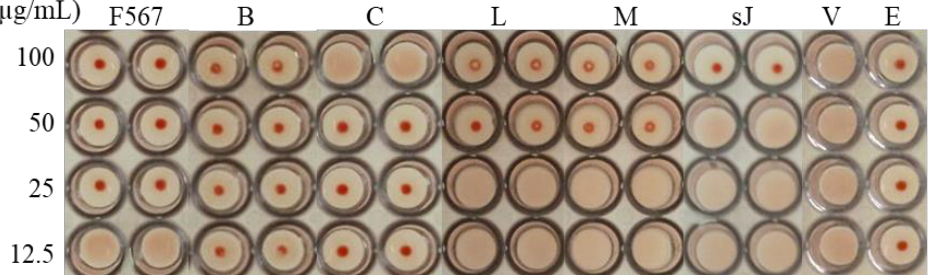
Figure 2. Hemagglutination inhibition activity of fractions F567, B, C, L and M and flavone sJ from the leaves of E. yucatanensis . Results: full inhibition (red button) or no inhibition (no red button). Controls: virus + erythrocytes (V) and erythrocytes (E).